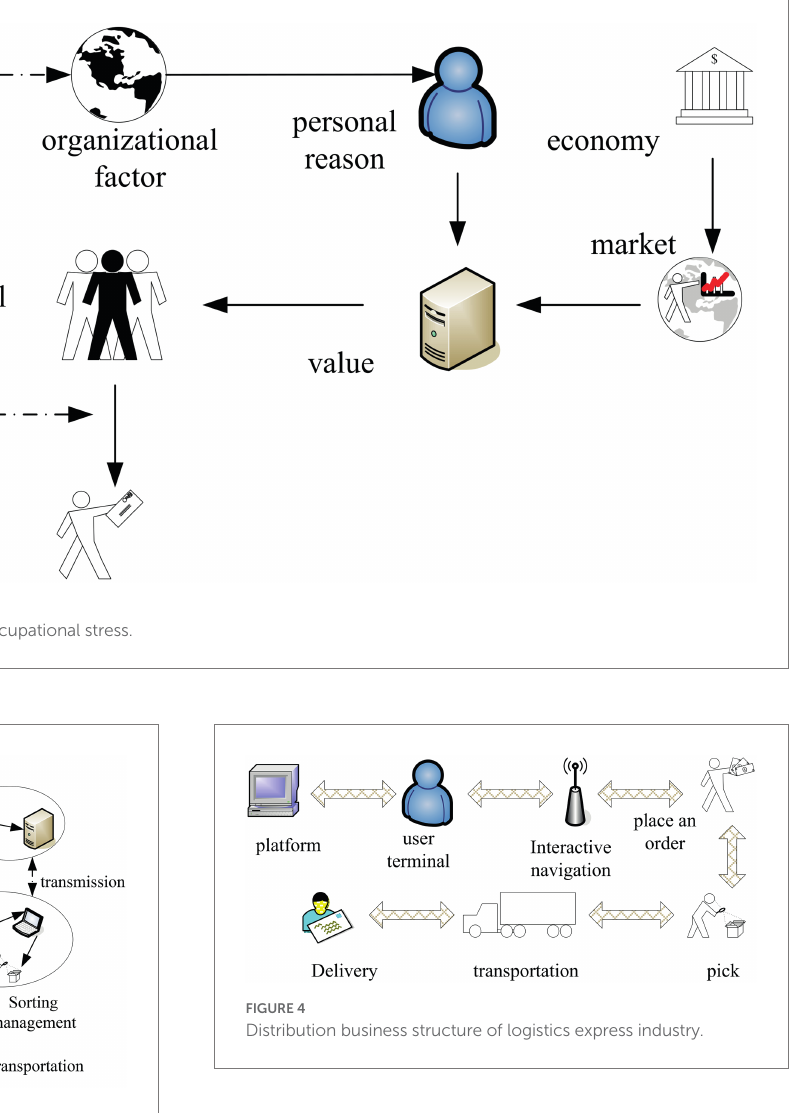
FIGURE 3 Workflow related to express delivery business.